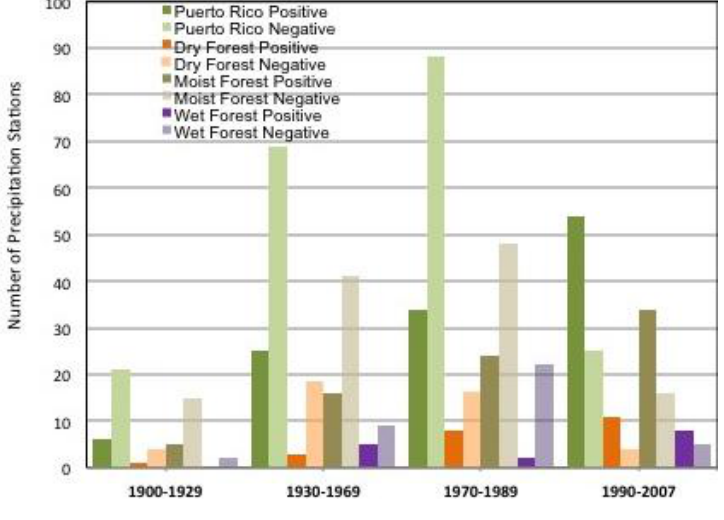
Figure 24. Number of stations with positive vs. negative trends by HELZ and